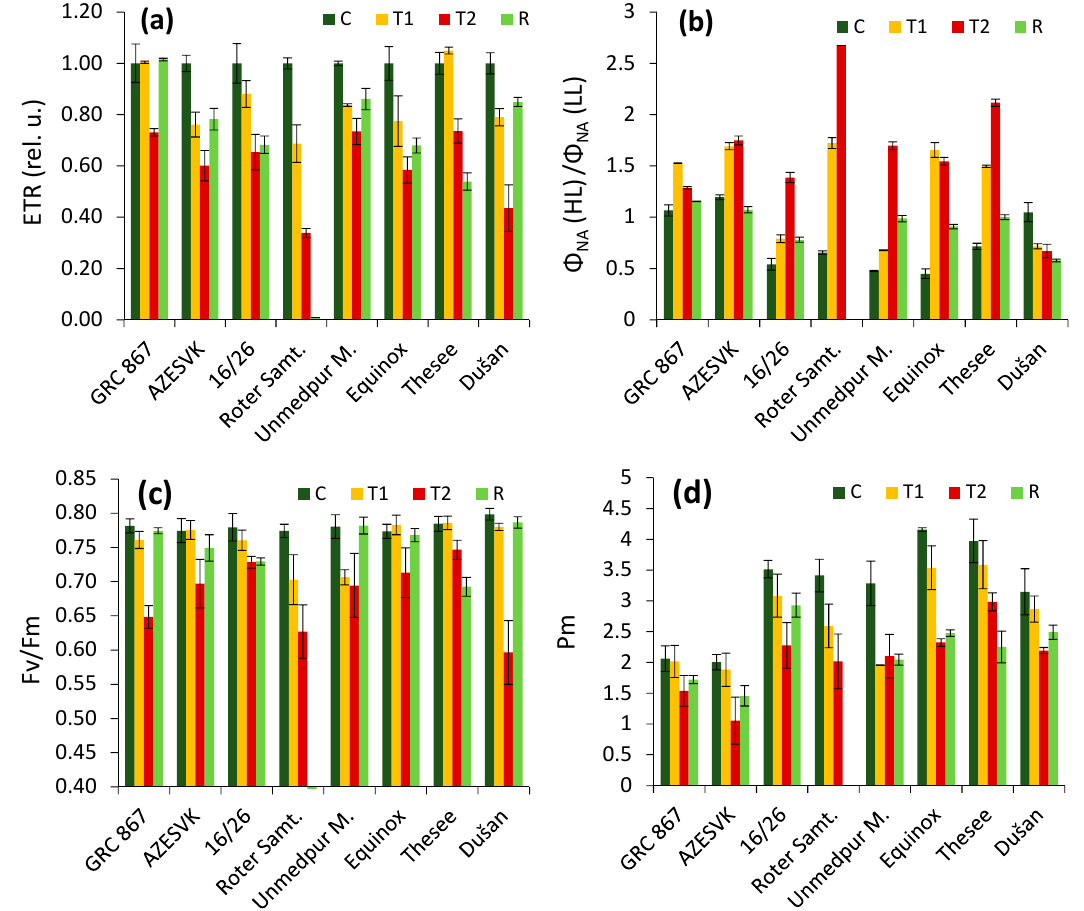
Figure 4. Effects of heat stress on parameters measured by Dual-PAM in different varieties: C, control; T1, thermal effect in the first phase; T2, thermal effect in the second phase; R, recovery phase. ( a ) The relative values of the electron transport rate (the average value of the control plants of each genotype equals 1). ( b ) The ratio of the acceptor side limitation measured in high light (HL, ~2000 μ mol m − 2 s − 1 ) and the value measured in low light (LL, ~40 μ mol m − 2 s − 1 ). ( c ) Maximum quantum efficiency of PSII photochemistry. ( d ) The maximum amplitude of P700 kinetics. Average values ± SE are presented.